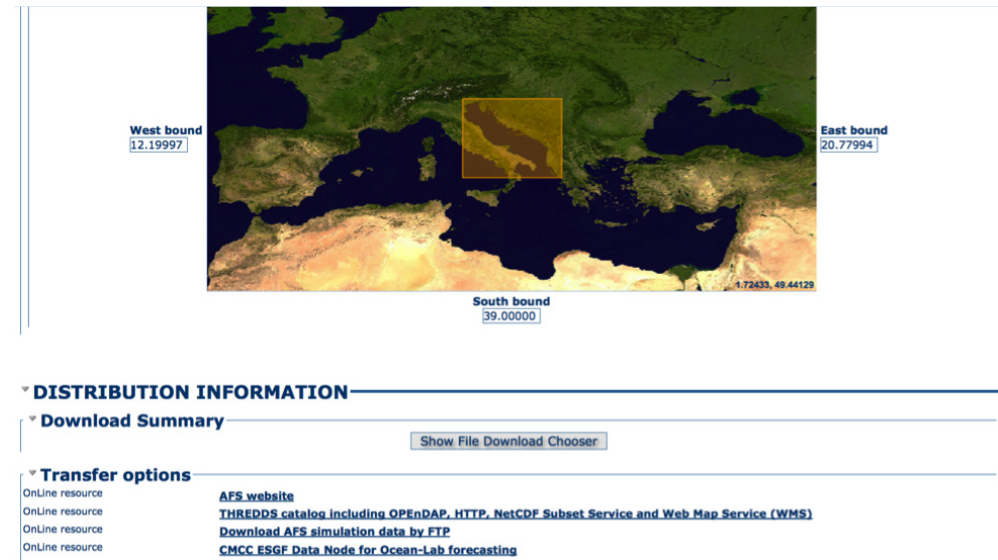
Figure 4. Metadata profile for an example of AFS